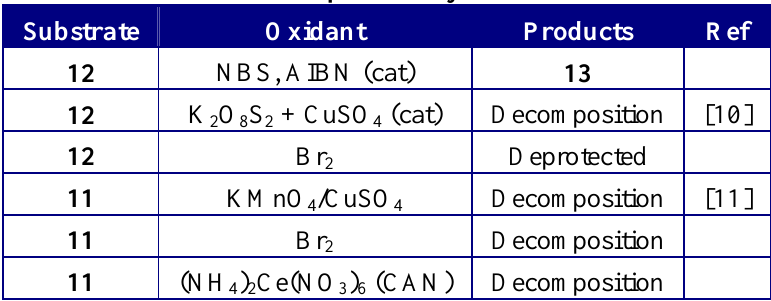
Table 1: Attempted Benzylic